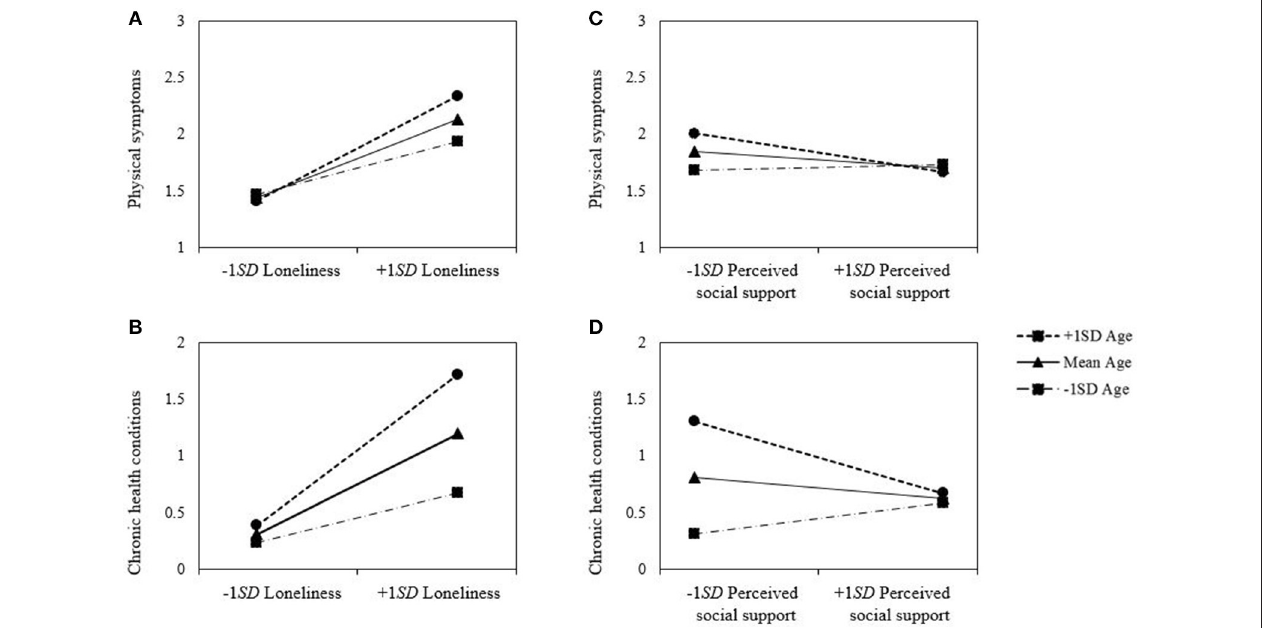
FIGURE 1 | Moderation effect of age on the relation between (A) loneliness and physical symptoms, (B) loneliness and chronic health conditions, (C) perceived social support and physical symptoms, (D) perceived social support and health conditions in Study 1.